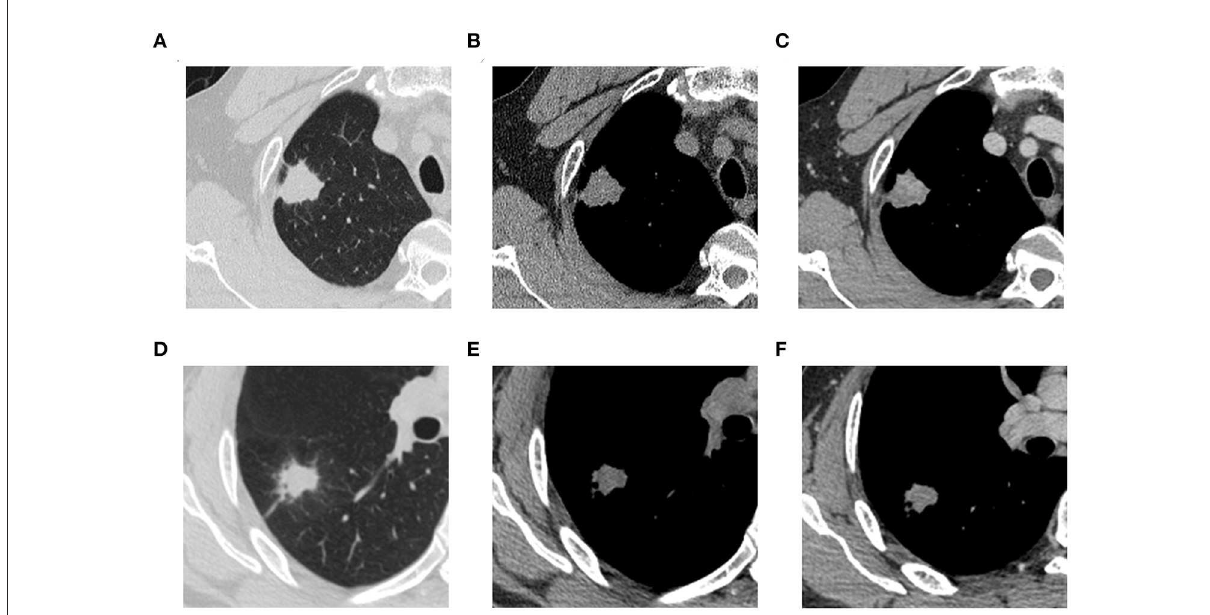
FIGURE2 (A) (NCECT, lung window), (B) (NCECT, mediastinal window), and (C) (CECT, mediastinal window) are thoracic CT images of a 53-year-old male patient with pathologically confirmed TB. (D) (NCECT, lung window), (E) (NCECT, mediastinal window), and (F) (CECT, mediastinal window) are thoracic CT images of a 41-year-old male patient with pathologically confirmed organized pneumonia. TB, tuberculosis; NCECT, non-contrast enhanced CT; CECT, contrast-enhanced